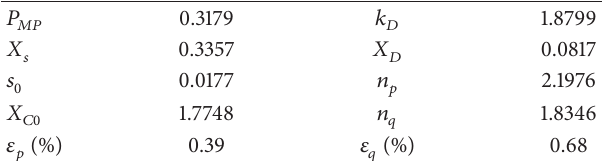
Figure 5: Flow diagram of load modeling based on AHP. Table 4: Parameter of SLM.